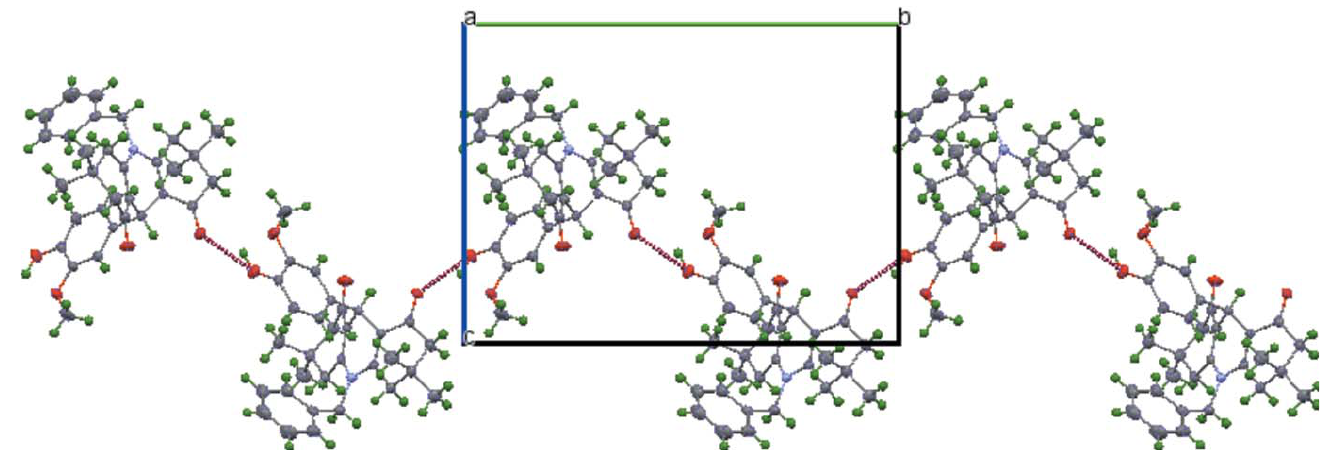
Figure 2 Packing view of the title compound showing the O—H (cid:2)(cid:2)(cid:2) O intermolecular hydrogen